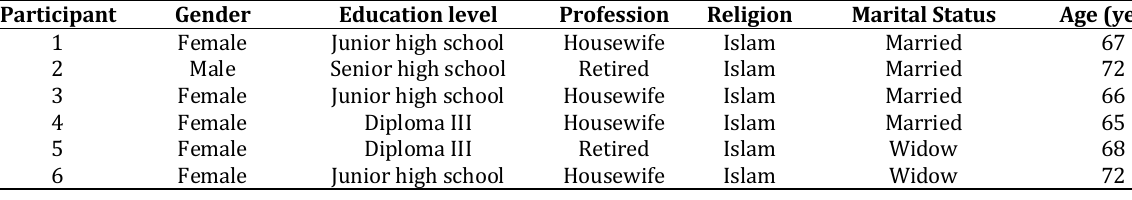
Table 2. Grandchildren